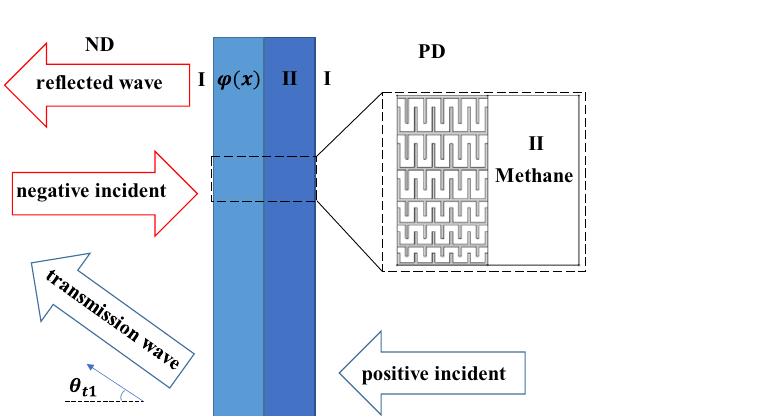
Figure 1. ( a ) Structure of the proposed acoustic device. ( b ) Basic unit of phase gradient structure. ( c ) The phase delay corresponding to each unit.